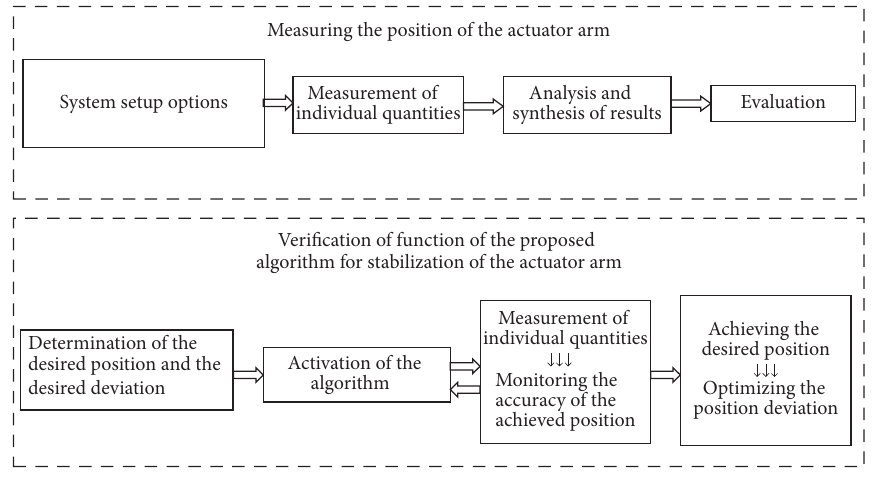
Figure 2: Schematic representation of the methodology of the measurement